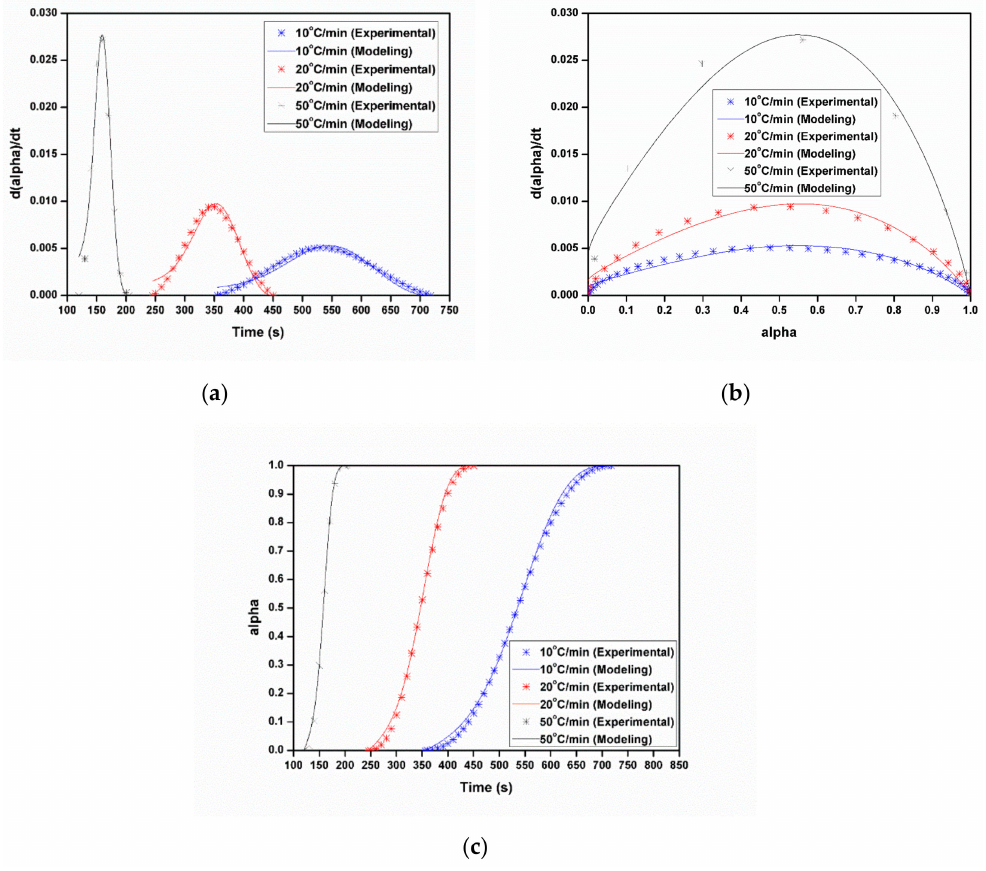
Figure 11. Comparison of modeling results to experimental data using the first order autocatalytic reaction model: ( a ) 10 ◦ C / min, ( b ) 20 ◦ C / min, ( c ) 50 ◦ C / min.